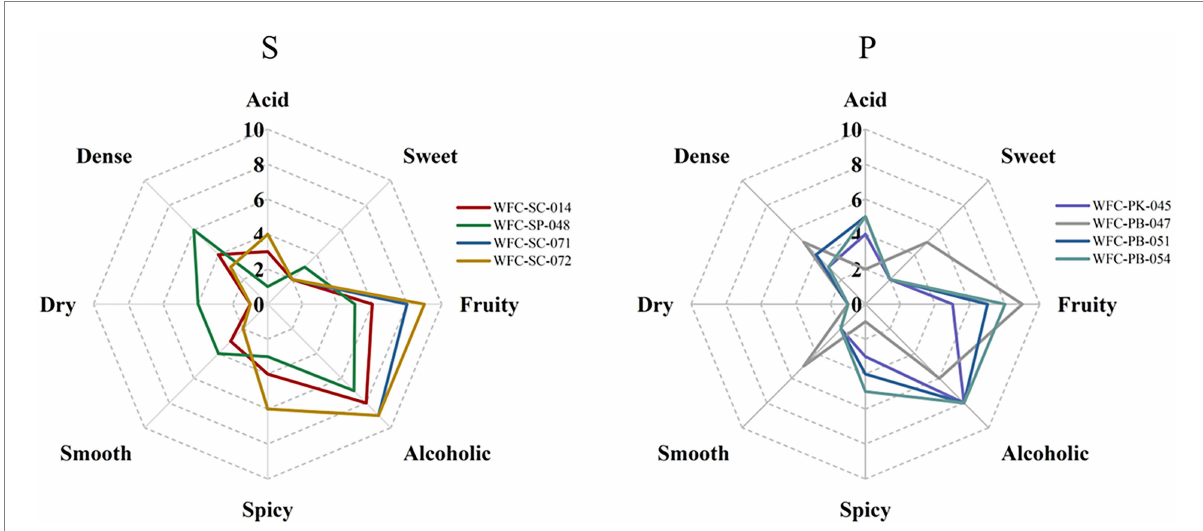
FIGURE 3 Sensory descriptive analysis of ciders fermented by Saccharomyces cerevisiae strains and Schizosaccharomyces pombe strain (S) or Pichia yeasts (P). Cider fermented by Saccharomyces cerevisiae strains WFC-SC-071, WFC-SC-072, or Pichia yeast WFC-PB-047 has desirable aroma characteristics for the cider style.